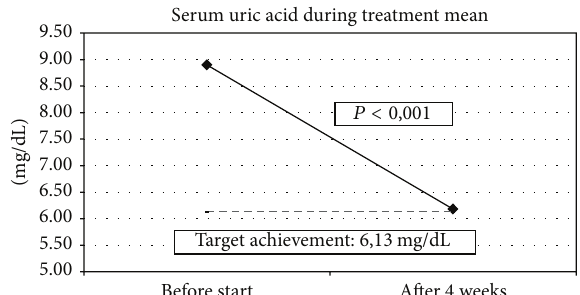
Figure 1: Decrease in serum uric acid levels during the 4-week treatment course with febuxostat .